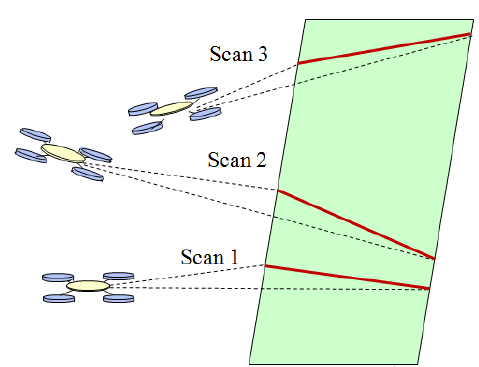
Figure 1. Observation of planar surfaces using multiple laser scans taken at consecutive platform